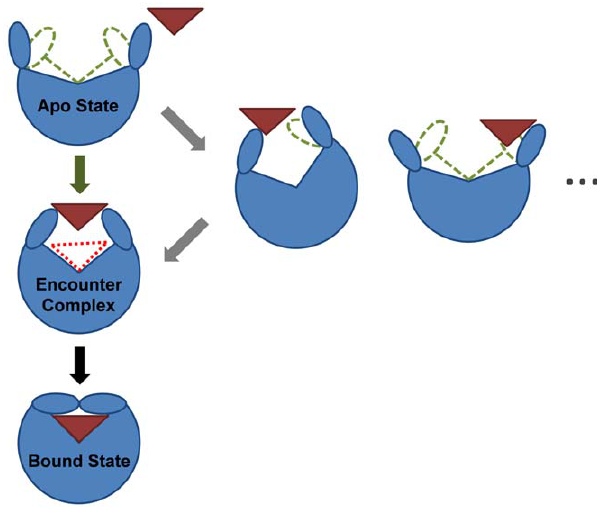
Figure 7. A schematic diagram describing the proposed two- step binding mechanism for proteins in steric occlusion of the direct binding of the ligands. The first step is the transition from the apo to the encounter complex state. In this step, multiple pathways exist where both conformational selection and the induced fit mechanisms play important roles. The second step is the transition from the encounter complex to the bound state, where the induced fit mechanism is